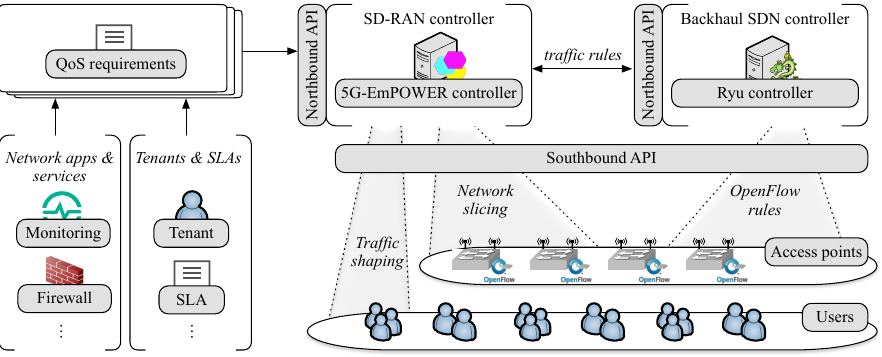
Figure 1. SDN-enabled layered network